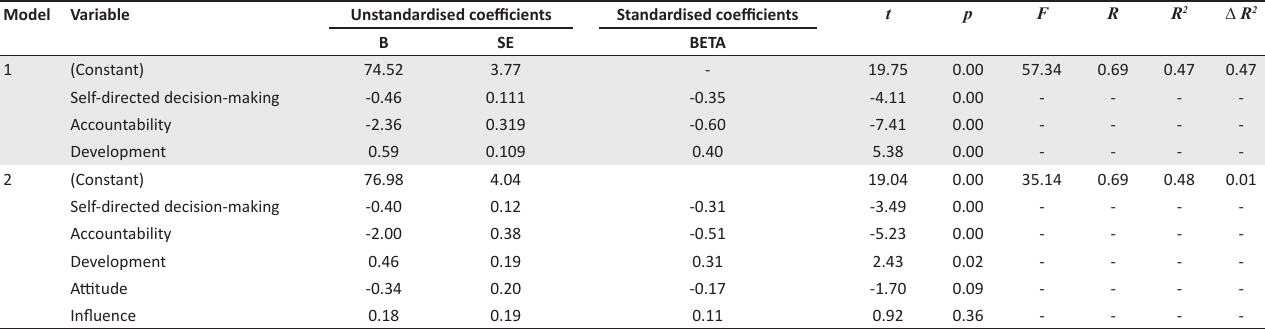
TABLE 5: Multiple regression analysis with deviant behaviour as dependent variable with leader empowering behaviour and psychological empowerment as independent variables. Model Variable